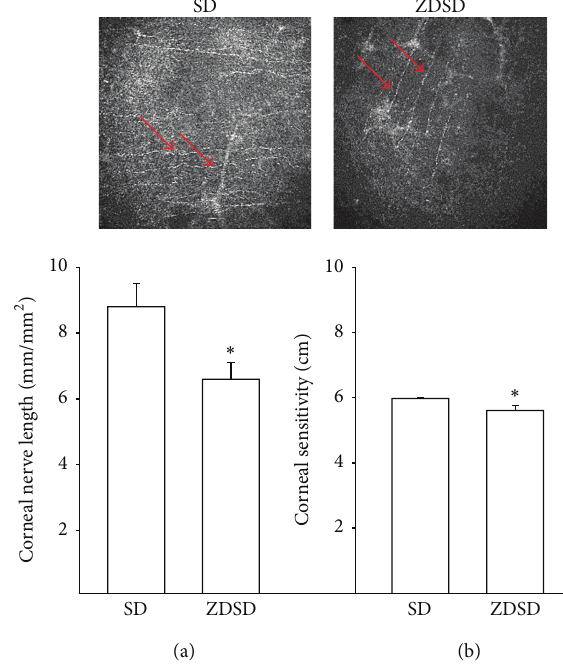
Figure 4: Corneal nerve fiber length and corneal sensitivity in age- matched Sprague Dawley and ZDSD rats. Corneal nerve fiber length (a) and corneal sensitivity (b) were examined as described in the Methods section in Sprague Dawley (SD) and ZDSD rats. Inserts are representative images of the subepithelial layer of the cornea from Sprague-Dawley (left) and ZDSD (right) rats. The red arrows point out the corneal nerves. The number of rats in each group was 10 and 9, respectively. Data are presented as the mean ± S.E.M. for corneal nerve fiber length in mm/mm 2 and corneal sensitivity in cm. ∗ 𝑃 < 0.05 compared to Sprague Dawley